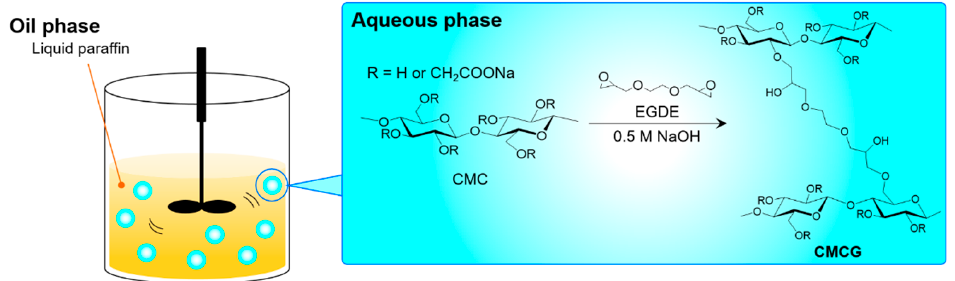
Figure 1. Preparation of the spherical carboxymethyl cellulose sodium salt hydrogel (CMCG) by the formation of a water droplet in liquid paraffin.